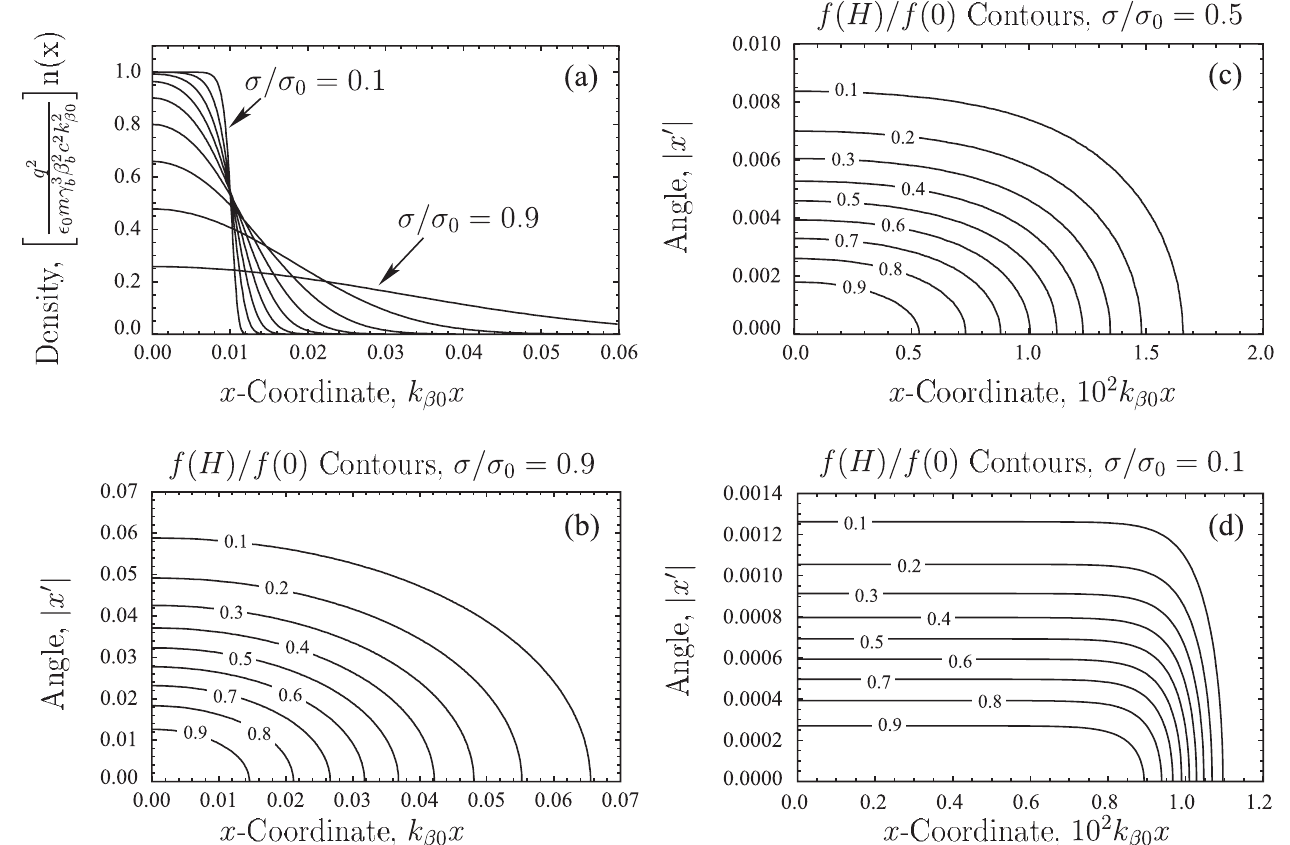
¼ 0 : 02 . In (a) the scaled density profile (cid:1) 0 x for rms-equivalent beam space-charge strengths (cid:7)=(cid:7) (cid:1) 0